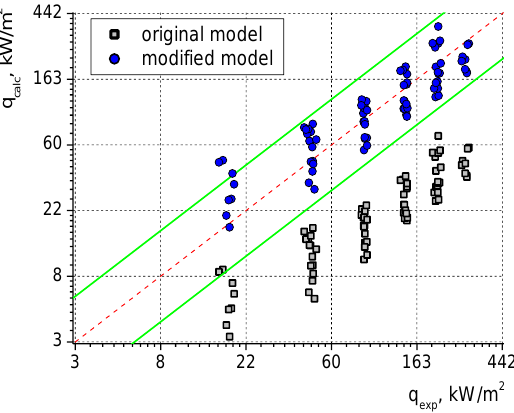
Figure 23. Experimental vs. model calculation results for the original and modified correlations; dashed red line: q calc = q exp and solid green lines: ±100% agreement bands.